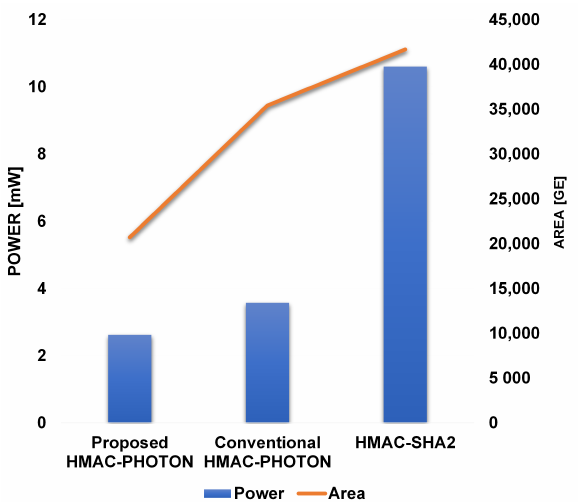
Figure 14. Power consumption of the proposed CBC-PRESENT when compared to a conventional design and AES.